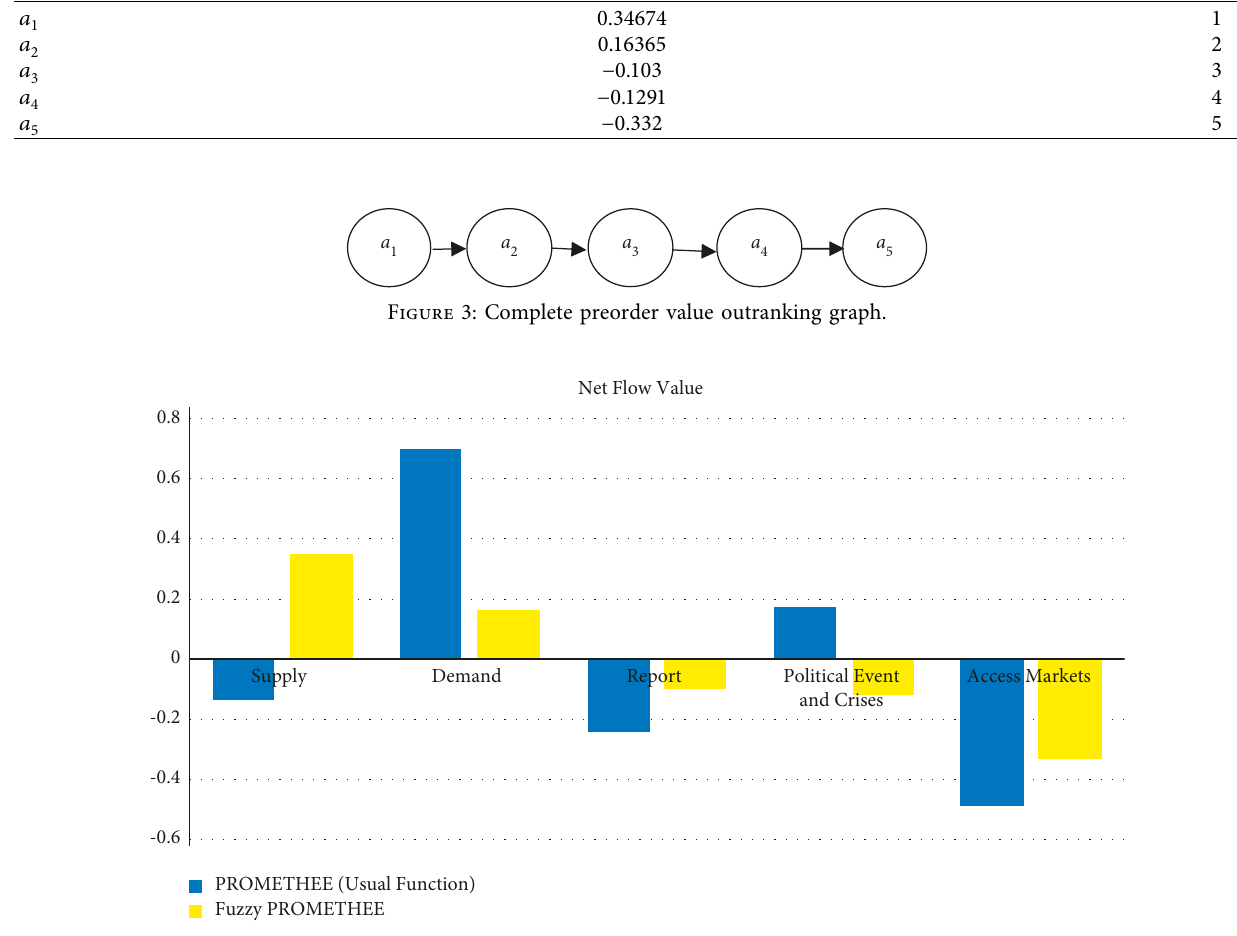
Figure 4: Net flow value between PROMETHEE and fuzzy PROMETHEE. Table 19: Ranking of Factors under PROMETHEE and fuzzy